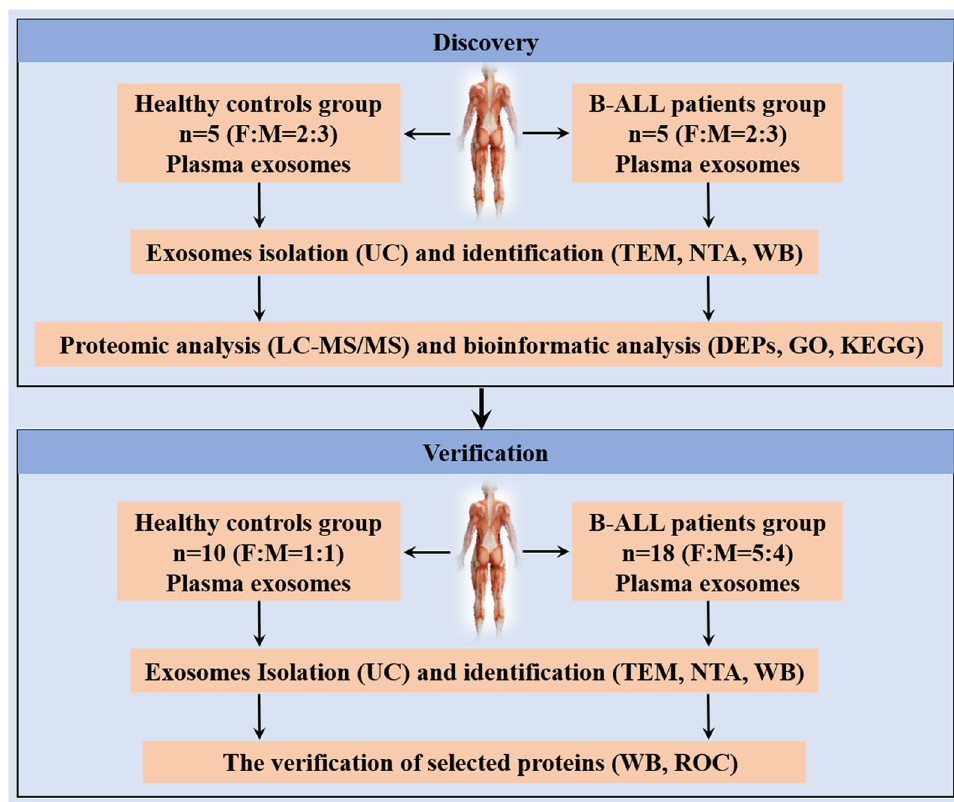
Figure 1. Schematic overview of the study. Discovery phase: prediction of the differentially expressed exosome proteins using proteomic and bioinformatic analyses. Verification phase: verification of selected differentially expressed exosome proteins by WB analysis and ROC curves. B-ALL, B-cell acute lymphoblastic leukemia; UC, ultracentrifugation; TEM, transmission electron microscope; NTA, nanoparticle tracking analysis; WB, western blot; ROC, receiver operating characteristic; F, female, M,